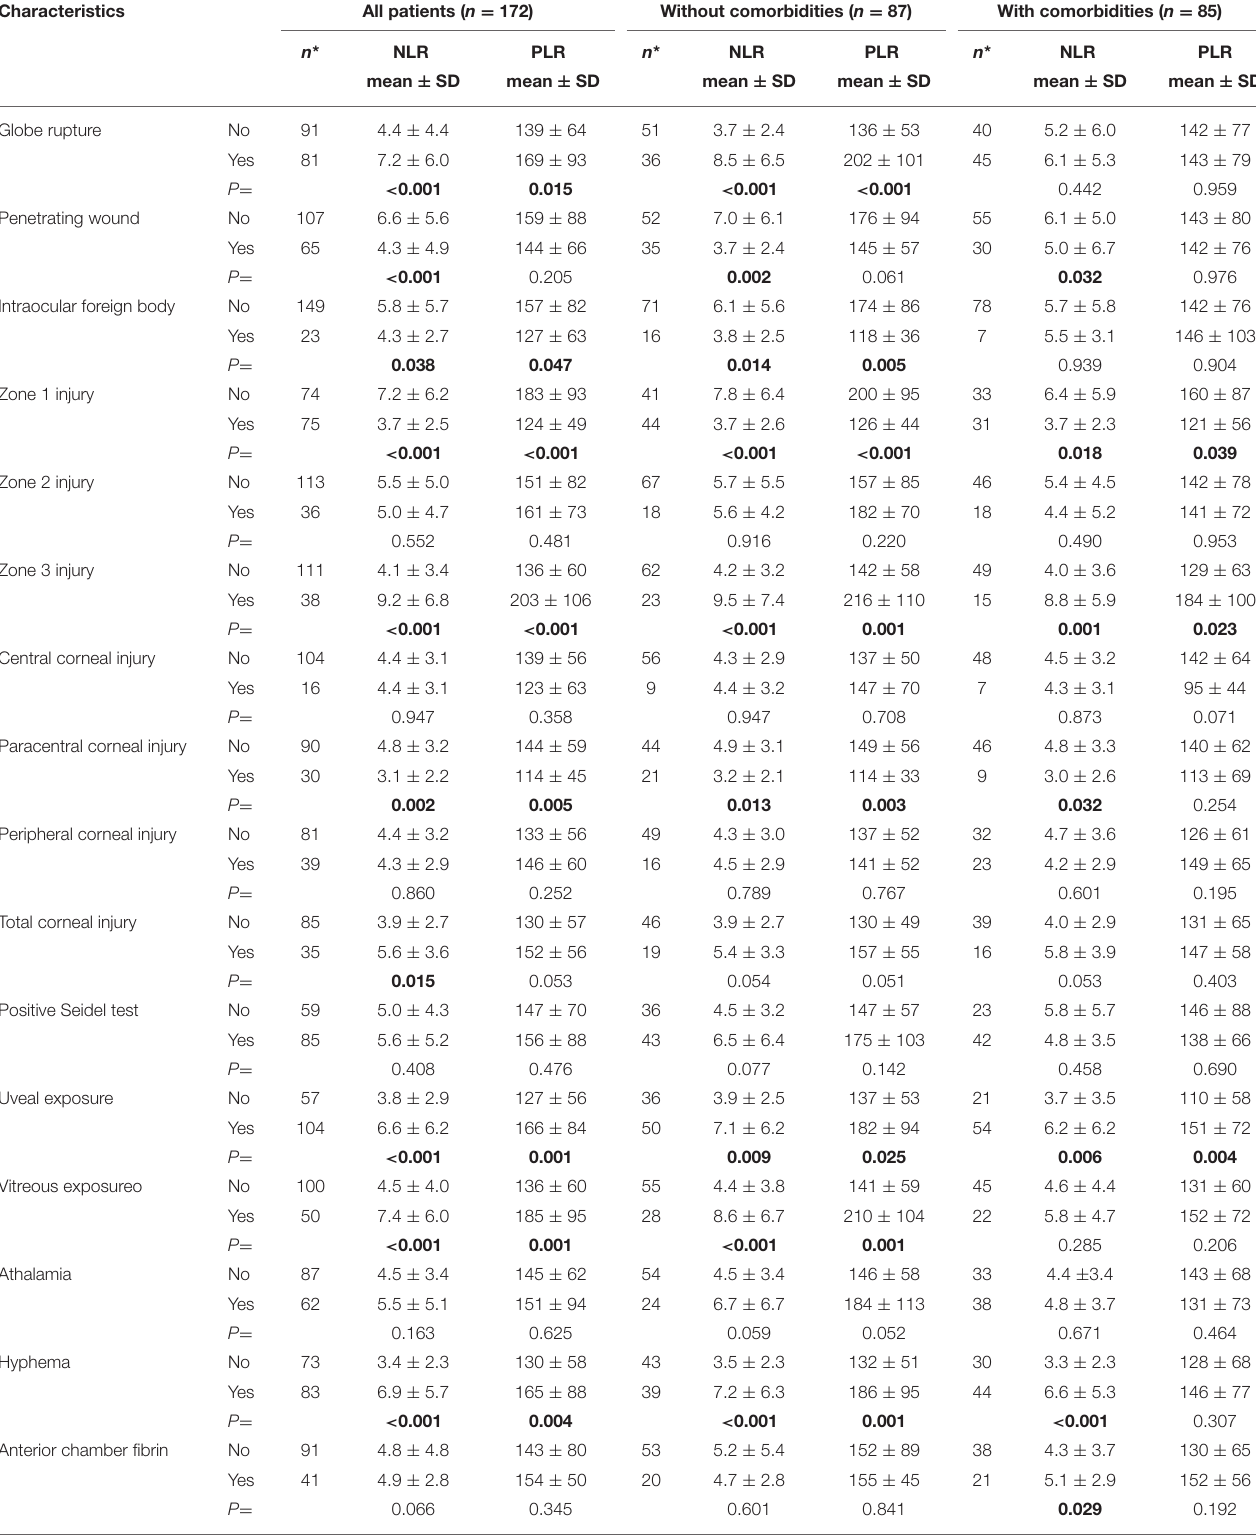
TABLE 4 | Clinical characteristics of OGI and its relationship with NLR and PLR. Characteristics All patients ( n = 172) Without comorbidities ( n = 87) With comorbidities ( n =